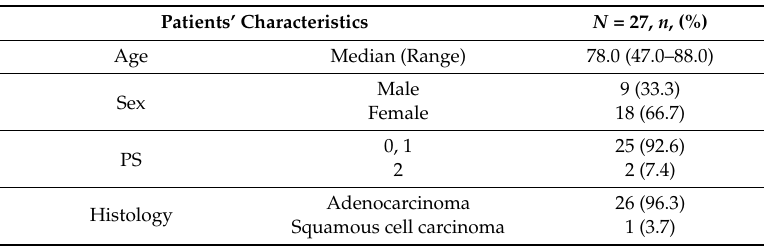
Table 1. Patients baseline